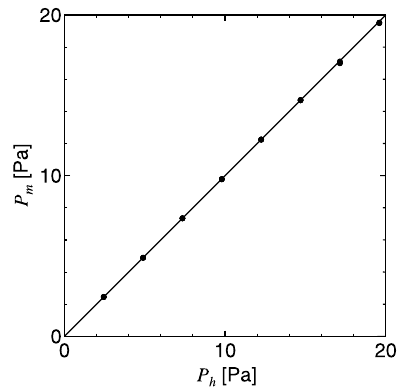
Fig. 6 Relation between the measured pressure P m and the theoretical value of the applied pressure P h